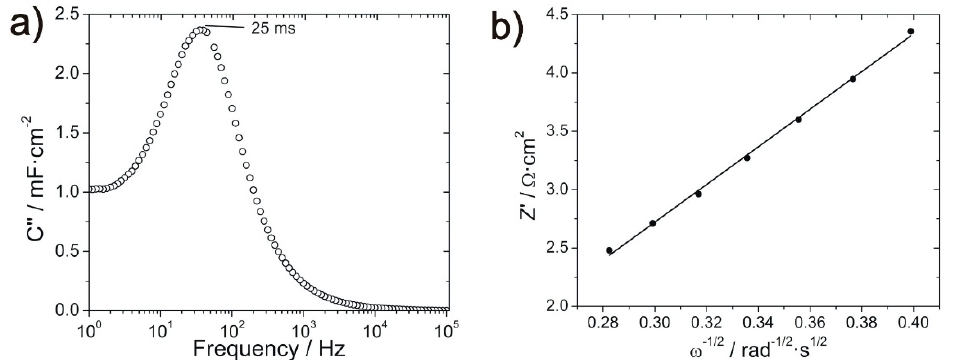
Figure 9. ( a ) C’’ vs. frequency plot to determine the relaxation time constant; ( b ) Z’ vs. ω 1/2 plot to evaluate the diffusion coefficient of MnO 2 /GNWs heated at 70 °C.